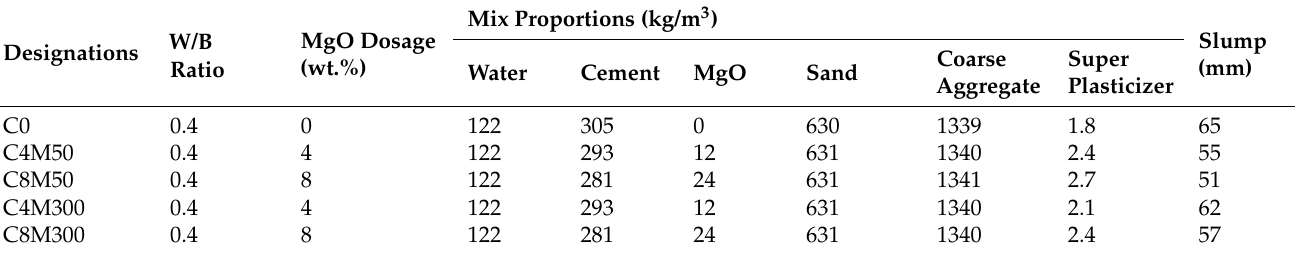
Table 2. Mix proportions and notations of